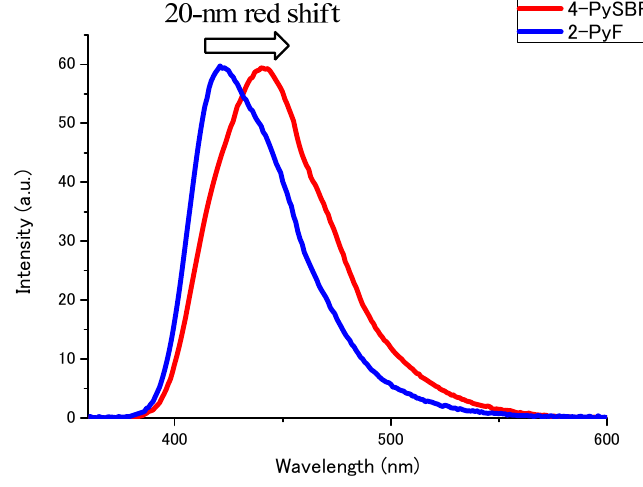
Cl ; Abs = 0.1, λ 2 2